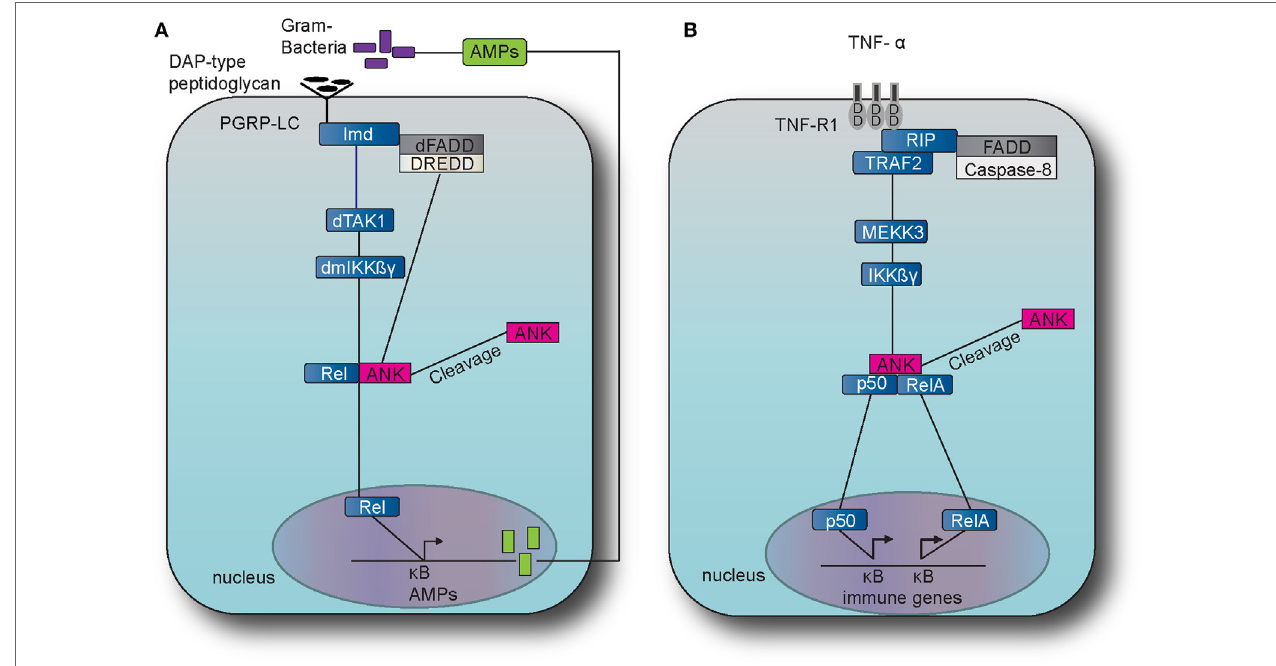
FiGURe 2 | The immune deficiency (IMD) pathway in fruit fly and the TNF pathway in the mouse. (A) The IMD pathway in Drosophila melanogaster is activated by Gram-negative bacteria and certain Gram-positive bacilli. The intracellular adaptor protein immune deficiency (Imd) interacts with the Drosophila Fas-associated death domain (dFADD) and the death-related ced-3/Nedd2-like caspase (DREDD) that cleaves Imd, which is then activated by K63 ubiquitination. This leads to the activation of the transforming growth factor beta activated kinase 1 (TAK1) that in turn activates the D. melanogaster inhibitor of kinase kinase ß and γ complex (dmIKKß γ ). Activation results in the translocation of the nuclear factor-kappa B (NF- κ B) transcription factor Relish (Rel) Dorsal to the nucleus which induces the transcription of antimicrobial peptide (AMP) genes, such as Diptericin. (B) The tumor necrosis factor (TNF) pathway in M. musculus is activated by TNF alpha (TNF- α ) which binds and activates the transmembrane receptors R1 (TNFR1) and recruits the receptor-interacting protein (RIP) and TNF receptor-associated factor 2 (TRAF2). TRAF2 employs mitogen-activated protein kinase kinase kinase 3 (MEKK3) which in turn activates the inhibitor of kinase kinase ß and γ complex (IKKß γ ), which results to the translocation of NF- κ B transcription factors p50 and Rel A. The latter translocation induces expression of several genes that are involved to immunity and